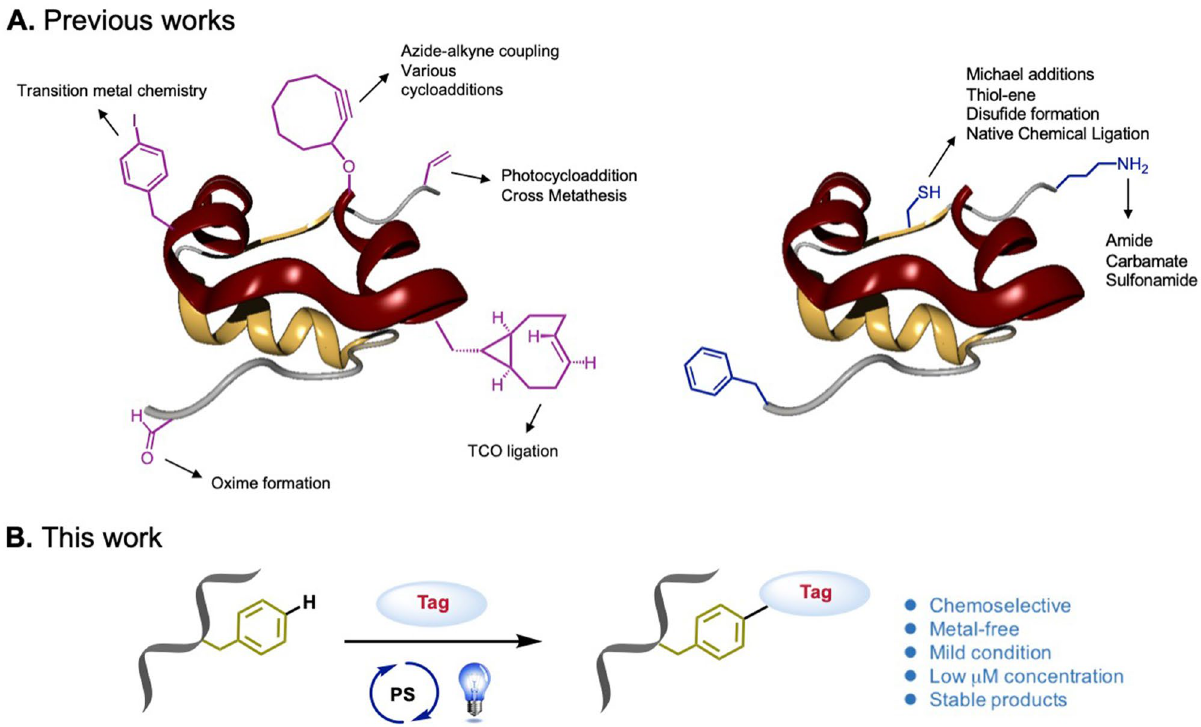
Figure 1. Site-selectivity approaches to protein modification. ( A ) Commonly used bioconjugal handles: non-natural handles, such as iodobenzyl, cyclopentaynyl, alkenyl, and oximyl groups, usually used for the functionalization of biomolecules; natural handles, Cys and Lys exploit their native chemical functionality. ( B ) General strategy for visible-light-induced site-selective phenylalanine